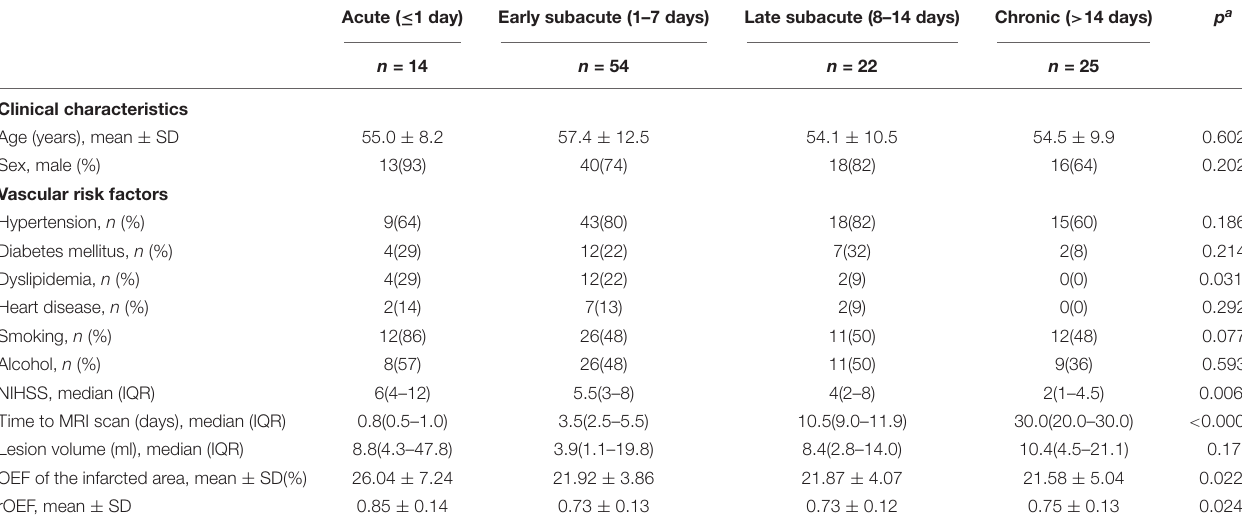
FIGURE 1 | Representative images of a 57-year-old male with right limb weakness. The final infarct (FI, with a volume of 8.3 ml on 9-day T2 fluid-attenuated inversion recovery (T2FLAIR) (shown in yellow) was smaller than the 58-h initial diffusion lesion (IDL, 13.18 ml) on diffusion-weighted imaging (DWI) (shown in red). The area of IDL that did not overlap with FI was the reversal region (RR). DWI, diffusion-weighted imaging; T2FLAIR, T2 fluid-attenuated inversion recovery; CBF, cerebral blood flow; OEF, oxygen extraction fraction. TABLE 1 | Group demographics and imaging characteristics of the 115 included